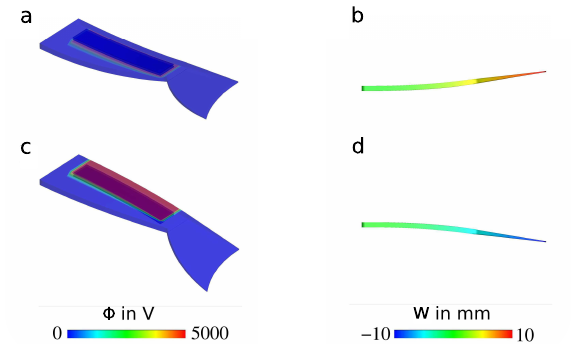
Figure 9. Quasi-static finite element simulation of the fish fin structure from Figure 8 with 3D views ( a , c : voltage scale) and side views ( b , d : deflection scale); the response of the structure due to the stimulation of ( a , b ) the bottom DEA and ( c , d ) the top DEA.